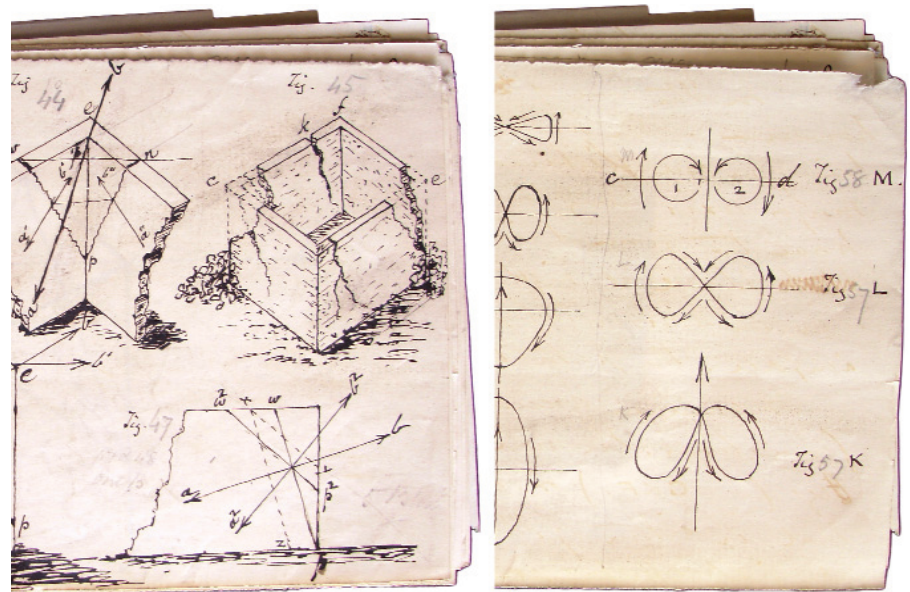
Figure 2. Particulars of the original drawings by Mallet to document the directions of the fractures in buildings having a rectangular plan hit by seismic waves (left), and the trajectories of the seismic-wave particles of different types (right).